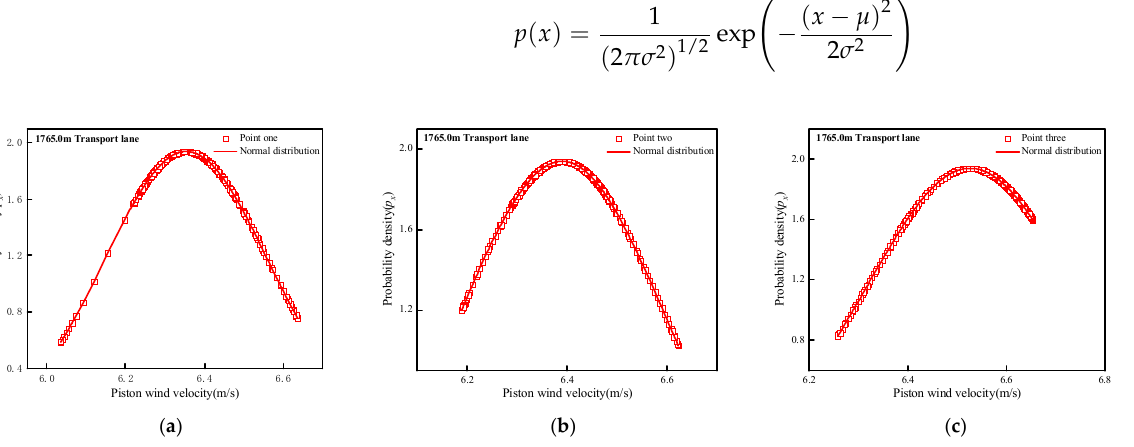
In the formula, p ( x ) is the probability density; x is the instantaneous airflow velocity of a point; μ is the sample average; 𝜎 is the standard deviation of the sample size.